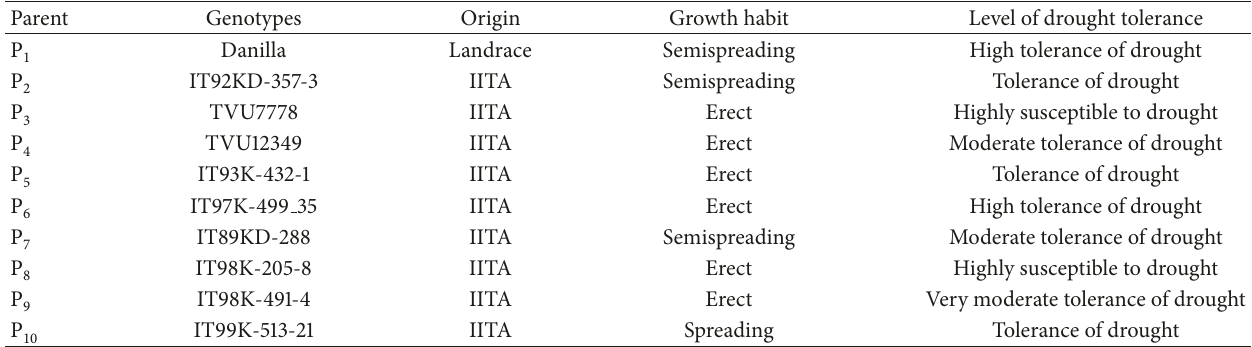
Table 1: Characteristics of cowpea genotypes